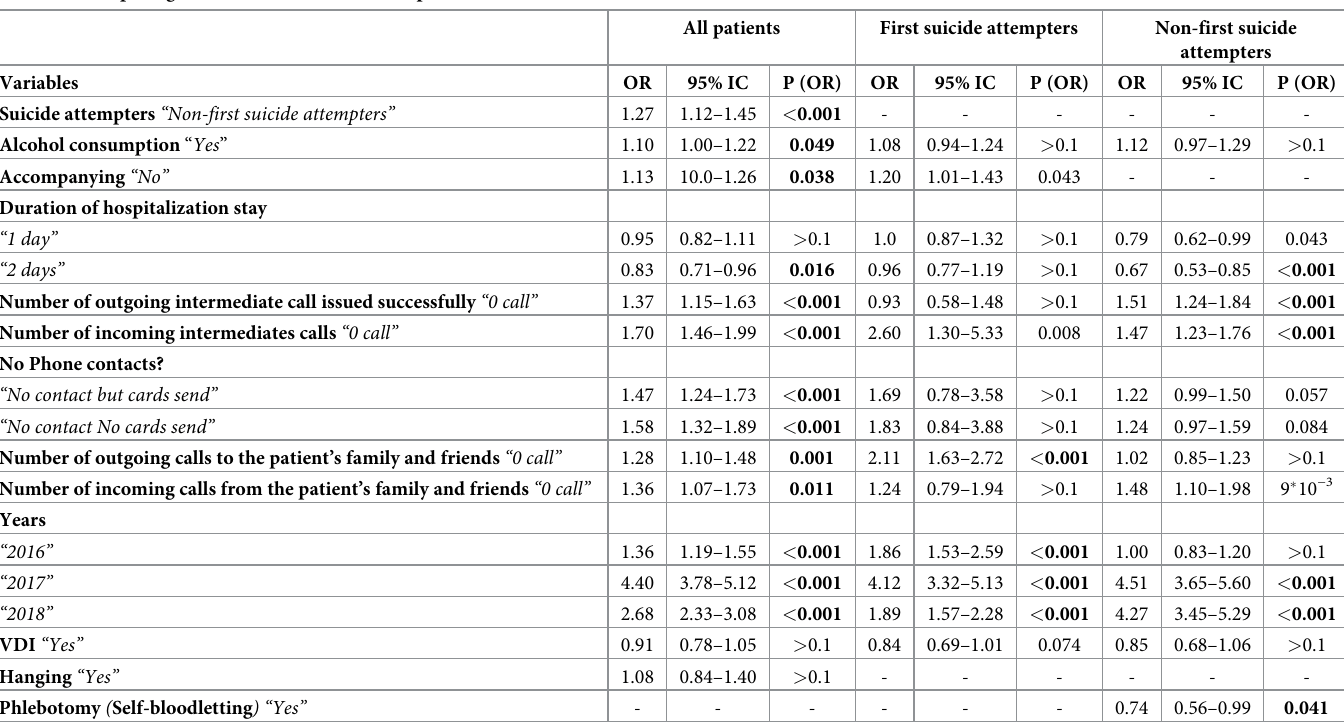
Table 4. Multiple regression of LFU and non-LFU